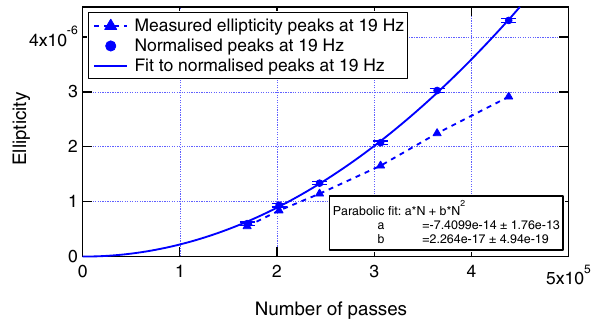
Fig. 9 Measured Faraday peak at ν F in the ellipticity channel as a function of N . The experimental points connected with dashed lines are not corrected for the cavity response. The dots lying on the parabolic fit are the experimental values corrected for the cavity response